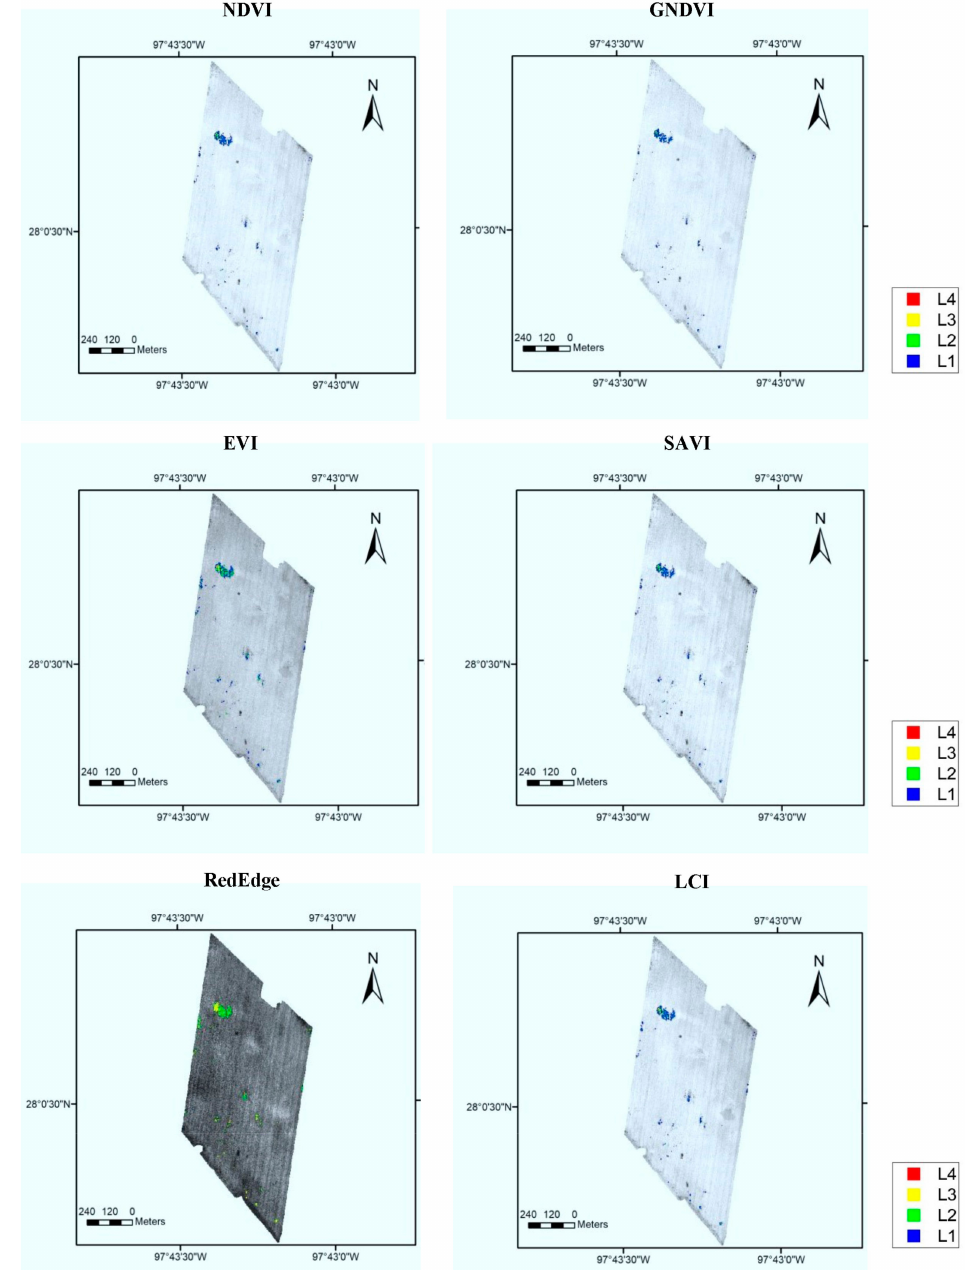
Figure 6. Distribution maps of the severity levels of cotton root rot in Field